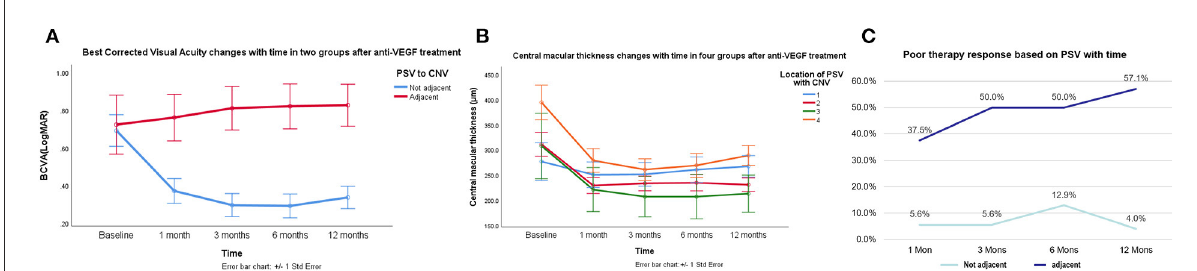
FIGURE3 Changes of BCVA and CMT based on PSV after IVI at a follow-up time of 12 months. (A) BCVA was transformed into normalized data analysis by its natural logarithm. The PSV was classified into two categories, PSV adjacent to CNV or not, the horizontal ordinate represents time, the vertical ordinate represents BCVA. There was a significant difference between the two groups by analysis of variance (ANOVA) ( F = 7.649, p = 0.009). (B) The changes in CMT were indicated in four types of PSV, 1 represents the trend of CMT change in the group PSVs adjacent to mCNV, 2 represents the trend of CMT change in the group PSV penetrated into the dilated choroidal vessels, 3 represents the trend of CMT change in the group PSVs passed under mCNV, and 4 represents the trend of CMT change in the group PSVs, which had no significant correlation with the position of mCNV; there was no significant difference between groups by the generalized estimating equation (GEE). (C) Poor therapeutic response based on the PSV with time, the PSV was divided into those adjacent to CNV and those not; there was a significant difference between the two groups, and the generalized linear mixed (GLM) model predicts that PSV adjacent to CNV is less likely to get a good response than PSV not adjacent to CNV.